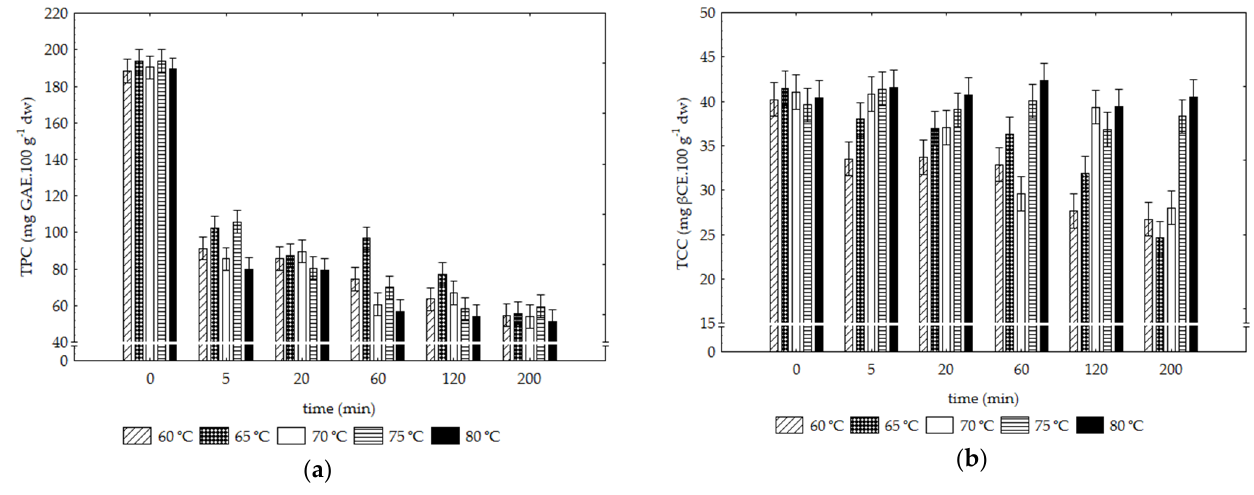
Figure 5. Sweet potato TPC ( a ) and TCC ( b ) changes in the function of temperature and time of drying. Vertical bars denote 0.95 confidence intervals.